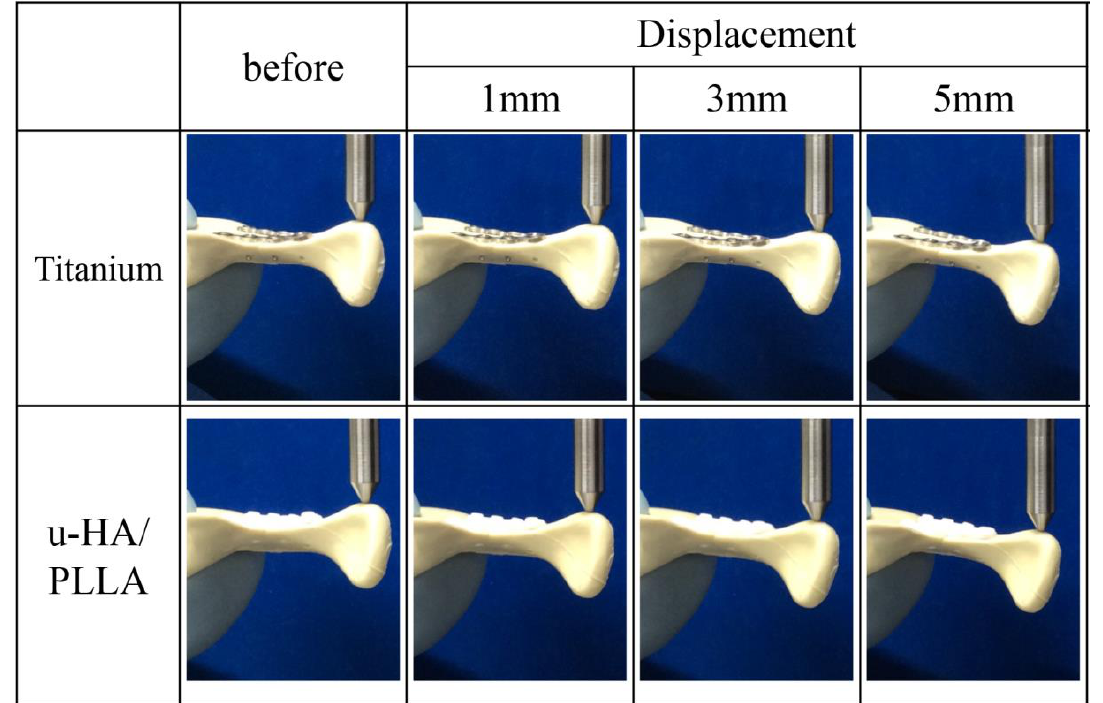
Figure 7. Change in subcondylar fracture segment under lateromedial loading. Ti, titanium (plates); u-HA/PLLA, unsintered hydroxyapatite/poly- L -lactide (bioresorbable plates).